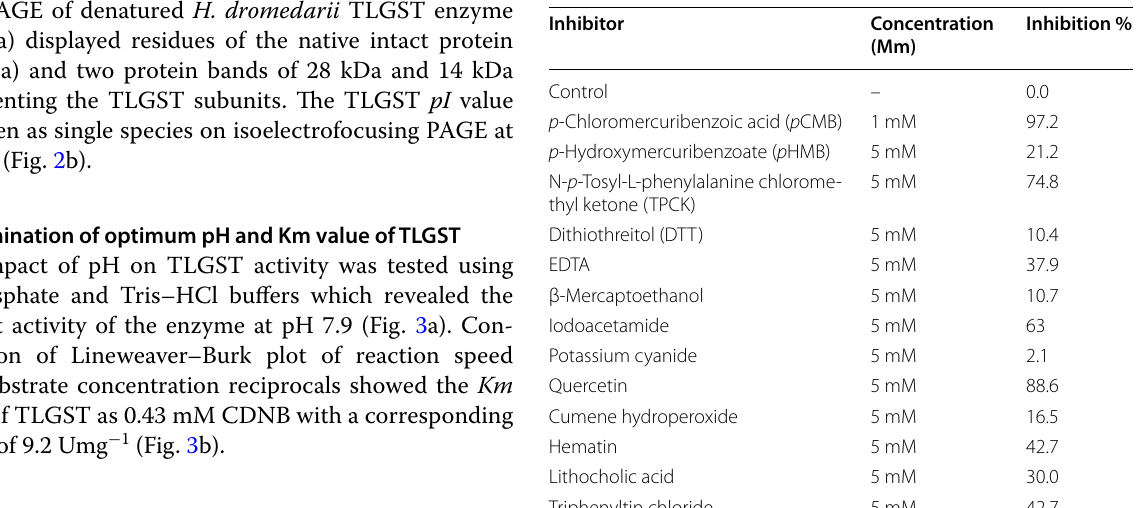
Table 3 Effect of inhibitors on the purified